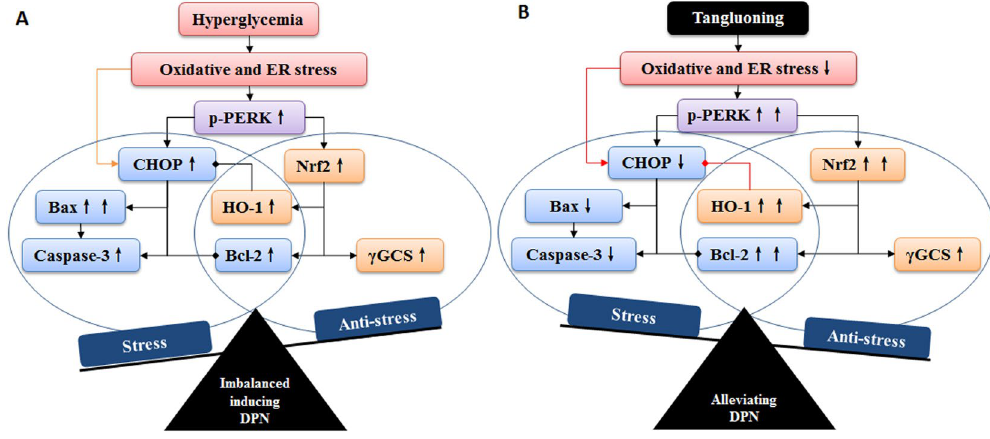
Figure 6. PERK/Nrf2 pathway in diabetic peripheral neuropathy and its regulation by